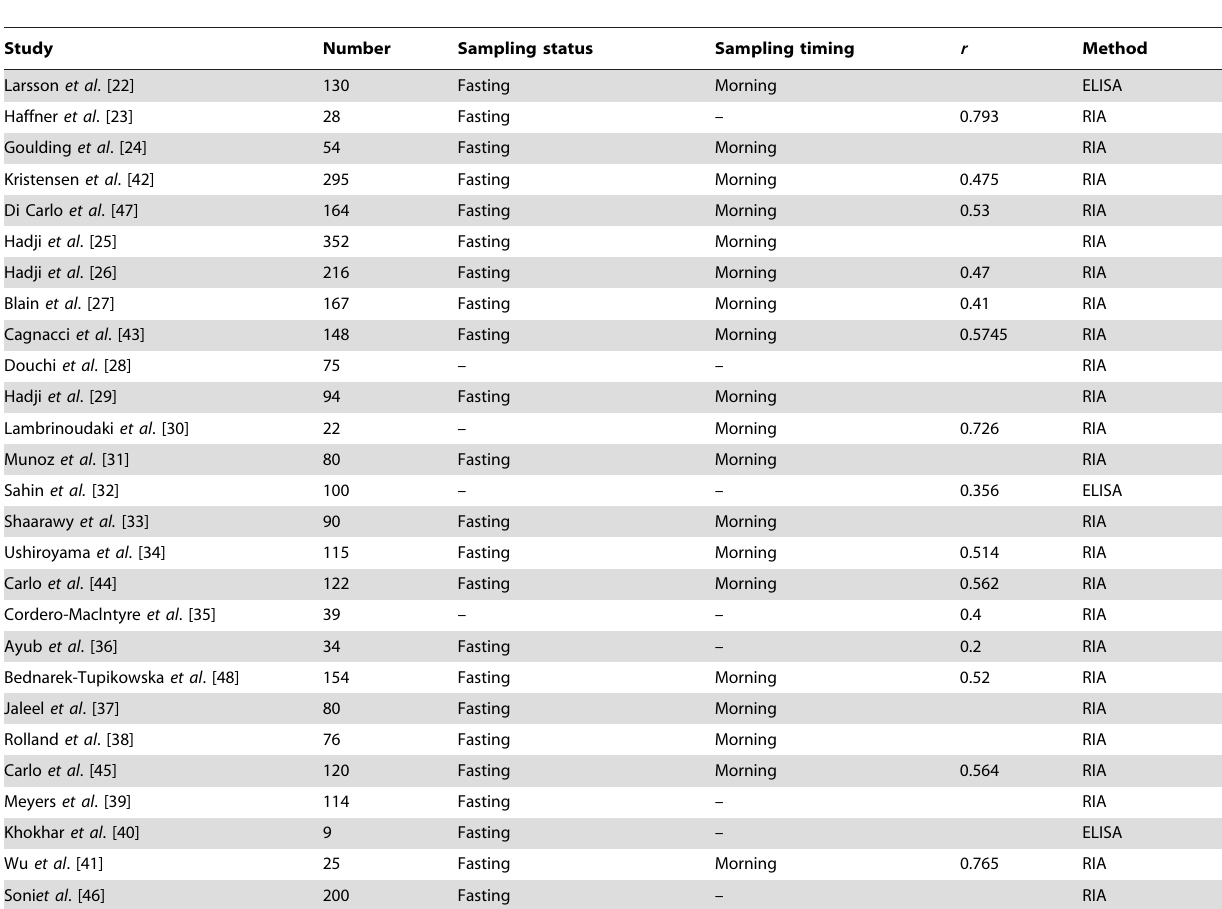
Table 1. Basic characteristics of all included studies and the r with the BMI.